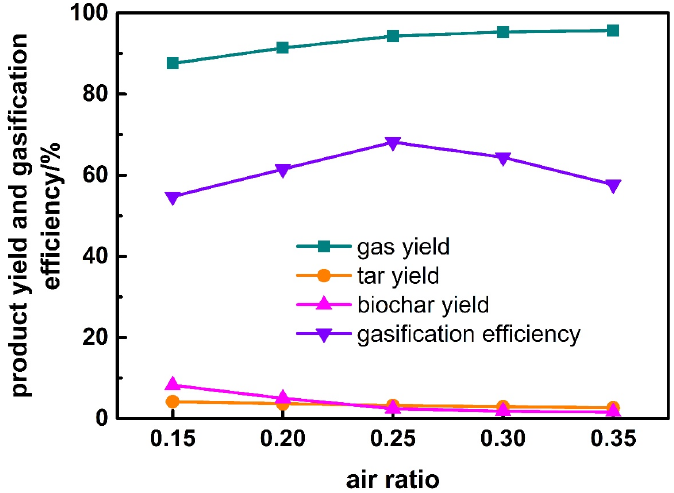
Figure 8. Effect of air ratio on product yield and gasification efficiency.